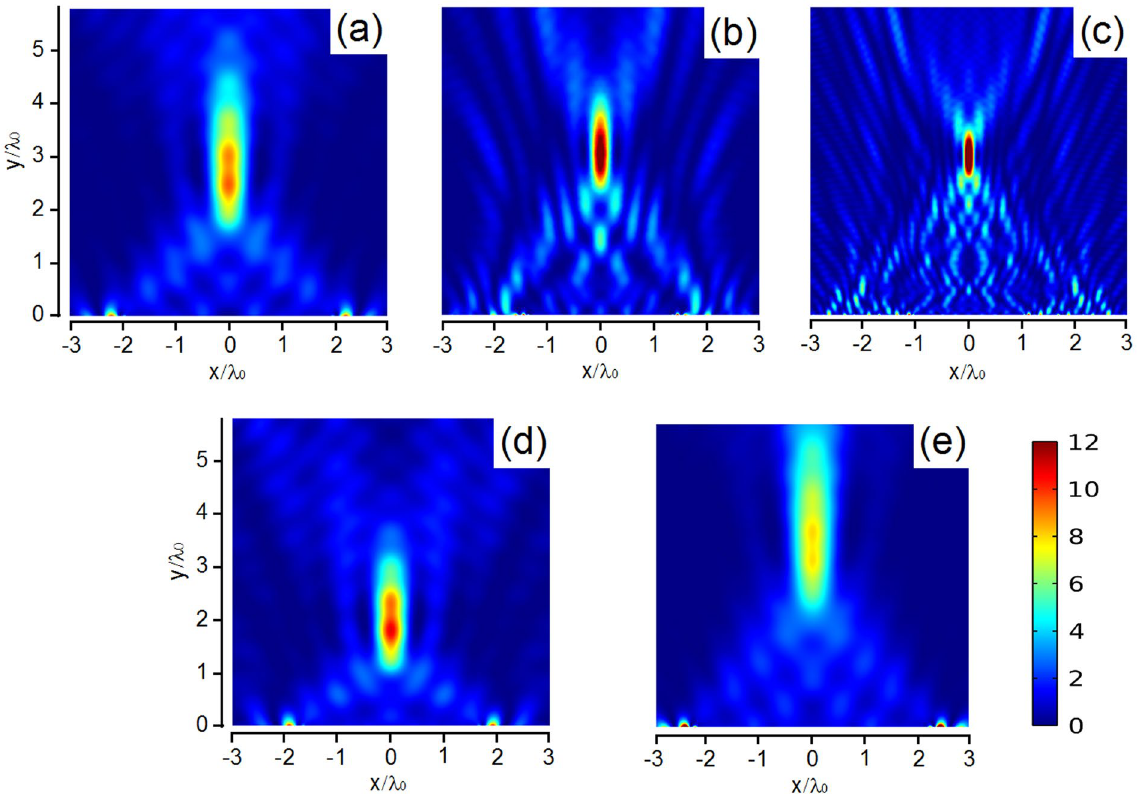
Figure 5. For the design focal length with 3 λ 0 , the reflected pressure intensity in the frequency of ( a ) 400 Hz, ( b ) 800 Hz and ( c ) 1600Hz. By changing the magnetic field distribution, the focal lengths are located near ( d ) (0, 2 λ 0 ) and ( e ) (0, 4 λ 0 ) in 400 Hz.